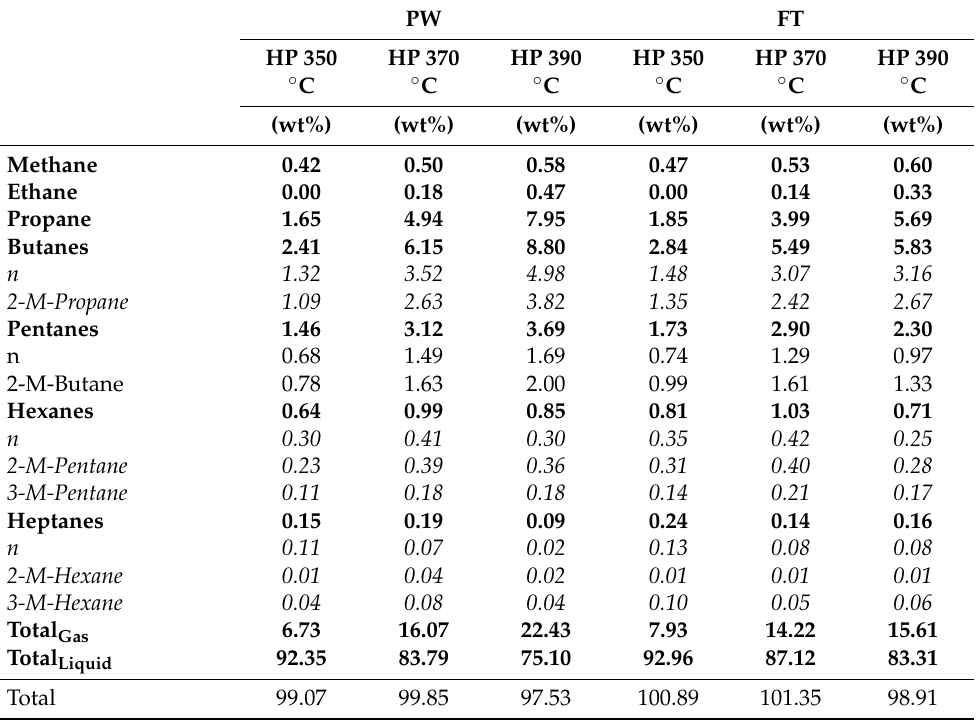
Table 6. Composition of hydrocarbon gases after PW and FT hydroprocessing experiments in relation to the introduced liquid feed.